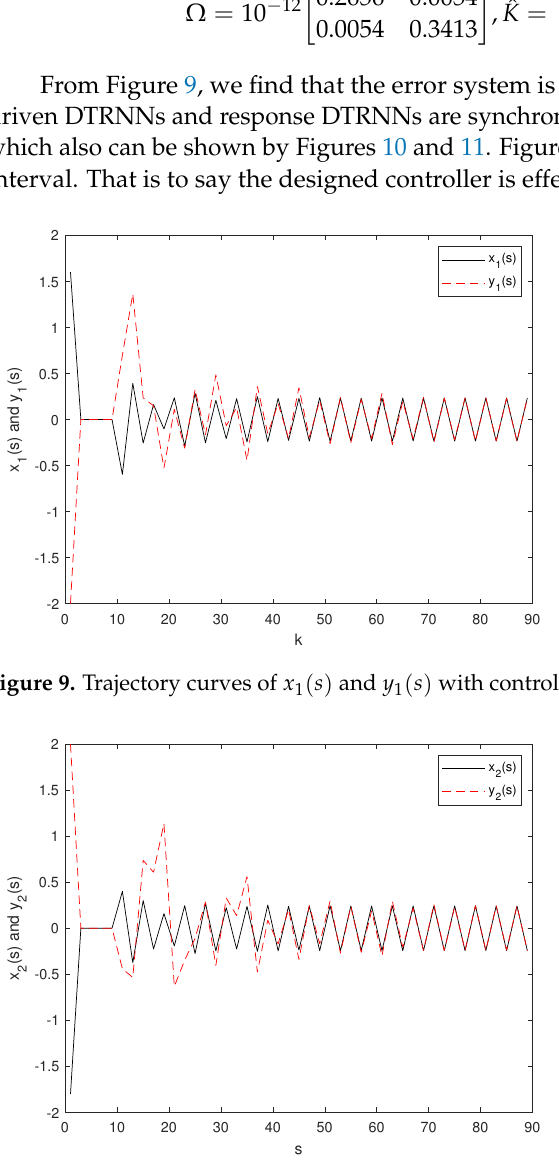
Figure 10. Trajectory curves of x 2 ( s ) and y 2 ( s ) with